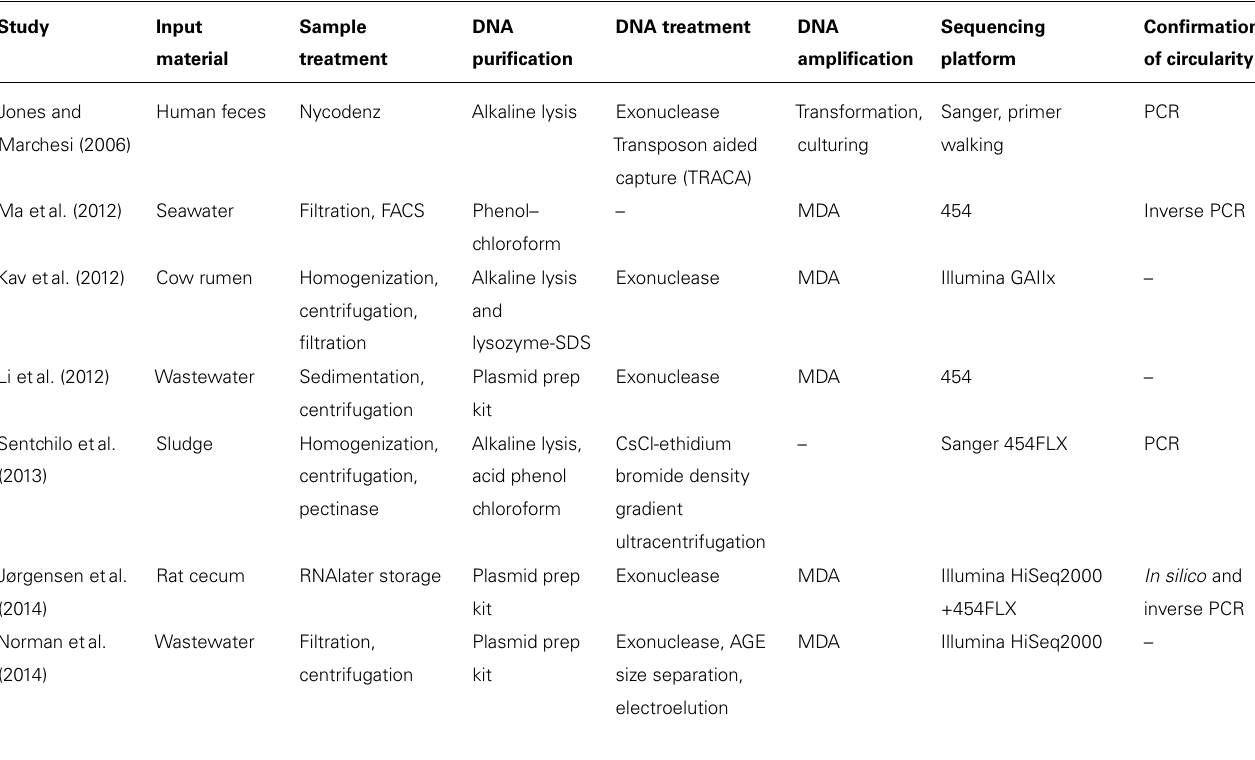
Table 1 | Routes for analyzing plasmid diversity in recent